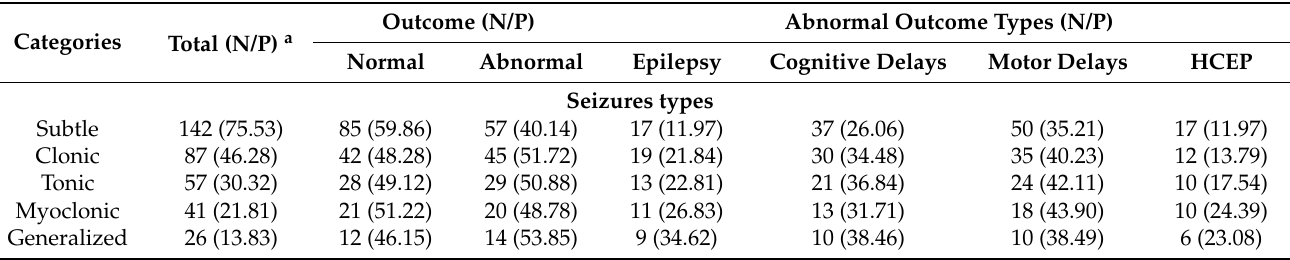
Table 3. Cases distribution based on seizure types in normal and abnormal outcomes.